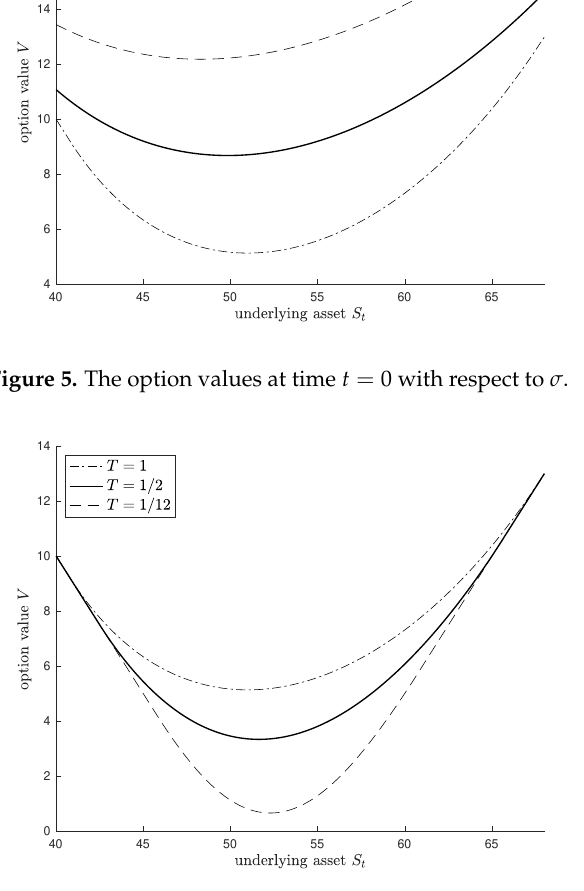
Figure 6. The option values V at time t = 0 with respect to the maturity T .